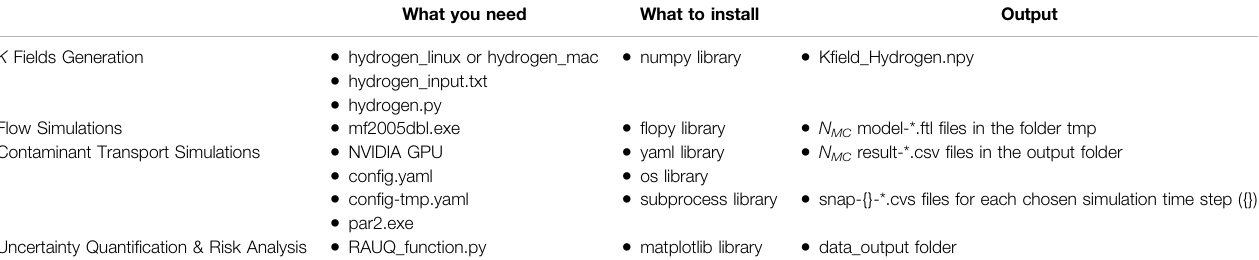
TABLE 2 | A list of software, Python libraries, con fi guration fi les for each step and the corresponding output data. Users need to install and prepare them to run the tutorial that reproduces the data and the analysis shown in this work. What you need What to install